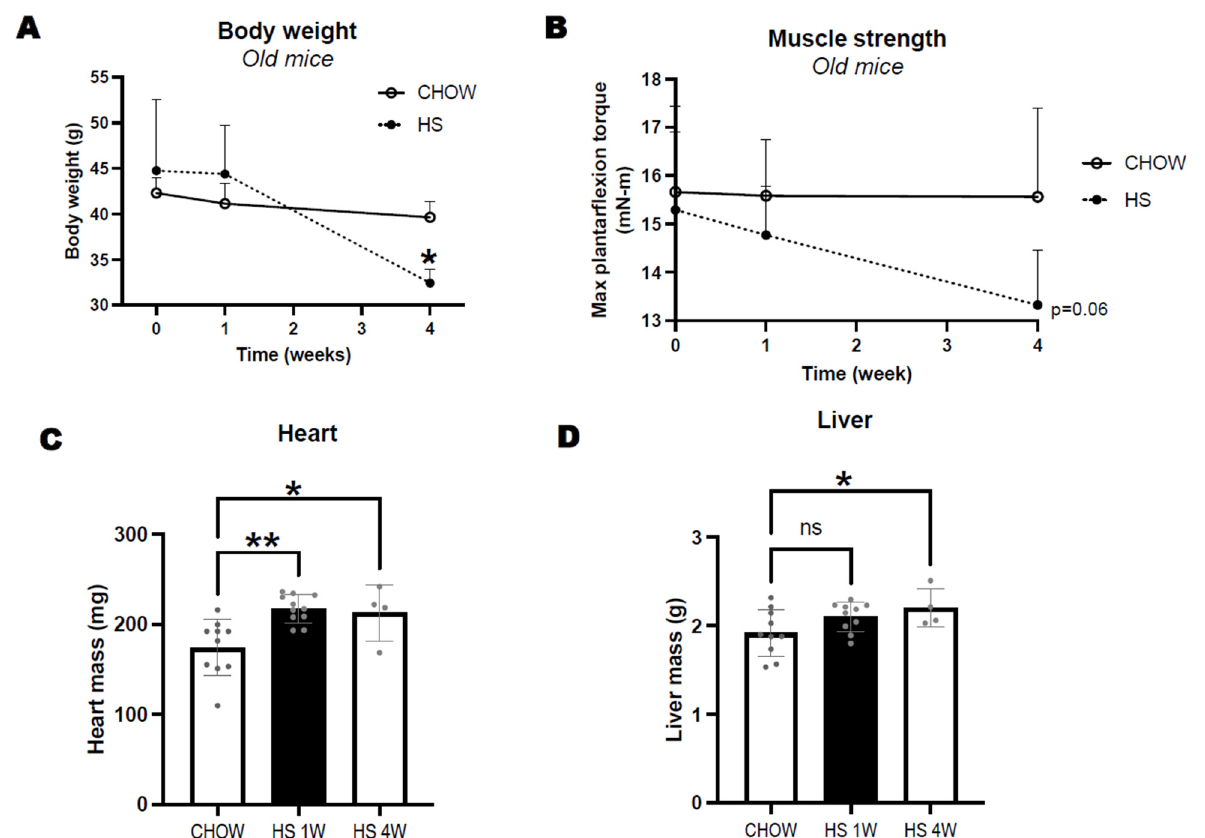
Figure 1. Changes in body weight ( A ) and maximal isometric torque of plantarflexors ( B ) in 24-month-old CB6F1 mice consuming either standard chow or high sucrose (HS) diet for 1 or 4 weeks. Differences in heart ( C ) and liver ( D ) mass between groups. Data expressed as mean ± SD. Significant differences to age-matched chow are indicated by * p < 0.05, ** p < 0.01, non–significant effects by